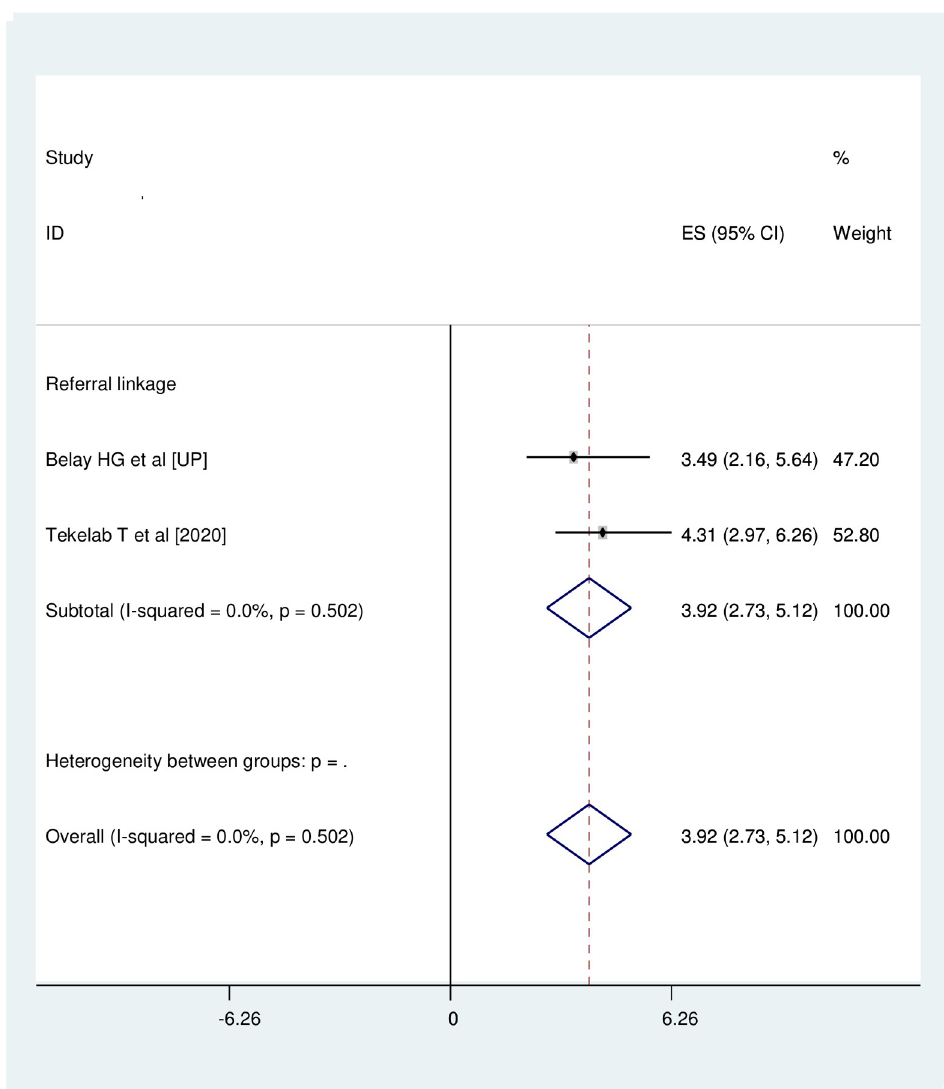
Fig 5. Association between referral linkage and neonatal near